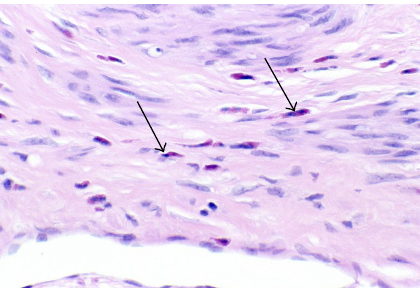
Figure 17: Leukocytes traversing fibrotic stroma of a fibroid tumor. Multiple ameboid eosinophils (arrows) with filopodial extensions are traversing the fibrotic stroma of this fibroid, seemingly unim- peded. Foci such as this indicate that the fibrotic stroma of fibroids can be penetrated by granulocytes and weakens the argument that the lack of inflammatory response to the dead and fragmented inanotic cells is due to the physical resistance of the dense fibrotic stroma in fibroids. Original magnification: